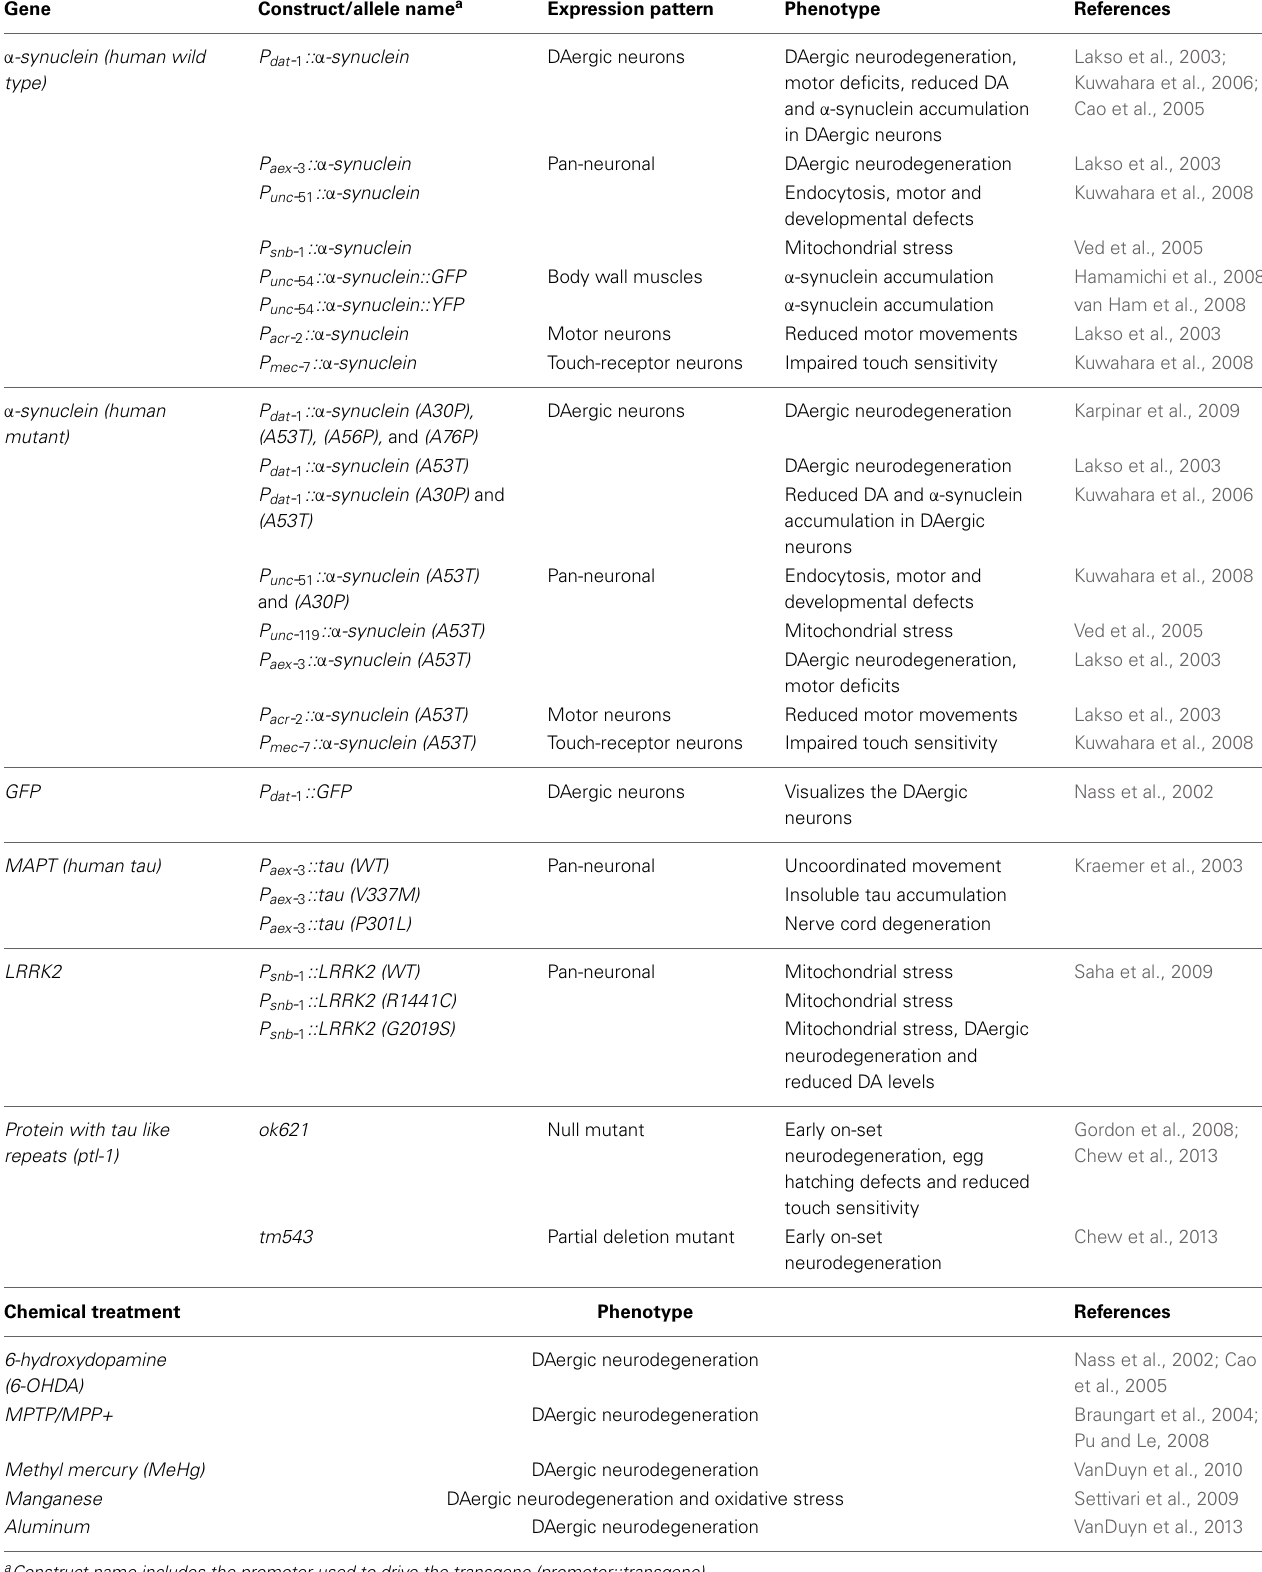
Table 2 | C. elegans Parkinson’s disease